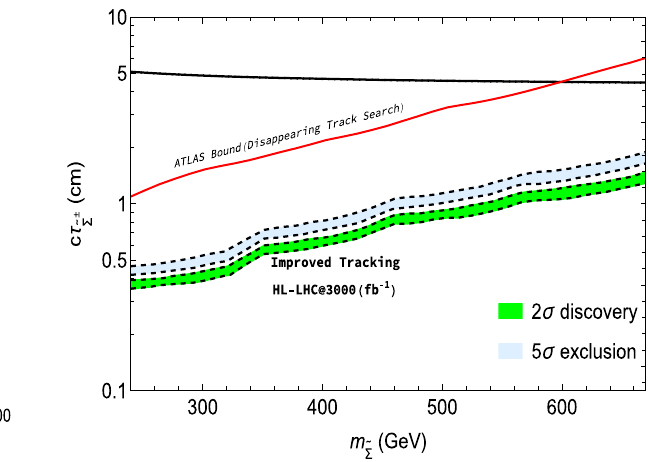
the LHC in Fig. 4. The right panel shows the prospect to search for ˜ (cid:2) ± disappearing track signature at high luminosity (HL)-LHC with 3000 fb − 1 luminosity. The solid horizontal black line depict the decay length of ˜ (cid:2) ± for both NH (IH) for the benchmark values θ 1 , 2 , 3 = 0, = 600 GeV, m (cid:2) ( m (cid:2) ) = 1 TeV and m = 10 − 9 m ˜ (cid:2) 1 ( 3 ) 2 , 3 1 , 2 1